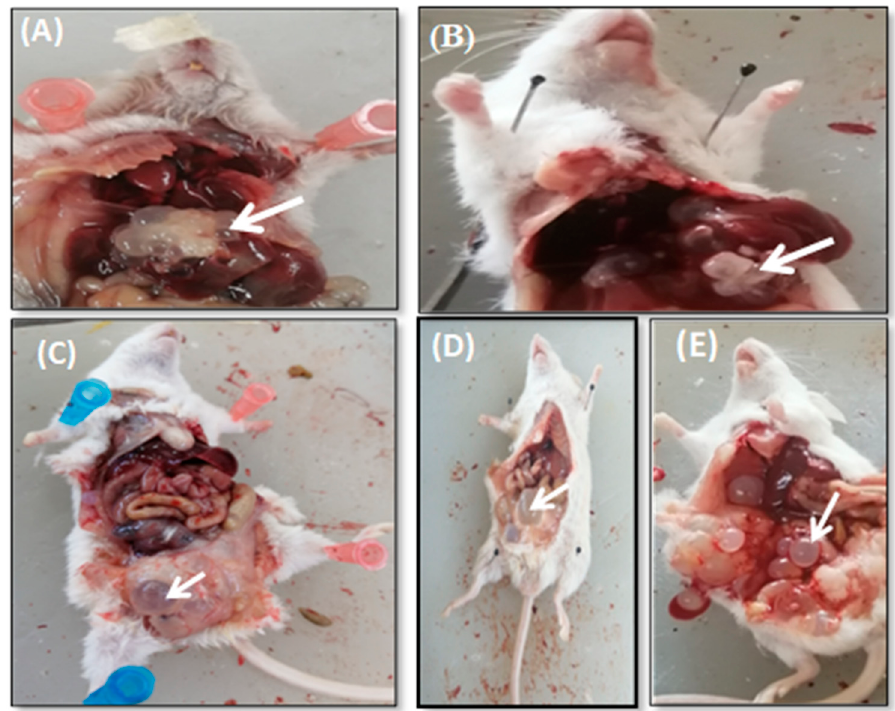
Figure 6. Transparent hepatic hydatid cysts in infected untreated mouse ( A ) compared with the milky or cloudy appearance of the hepatic hydatid cysts in mouse treated with AgNPs for one month ( B ); ( C ) shows transparent hydatid cyst in the peritoneal cavity in infected untreated mice; ( D , E ) shows cloudy appearance of hydatid cysts in infected treated mice.